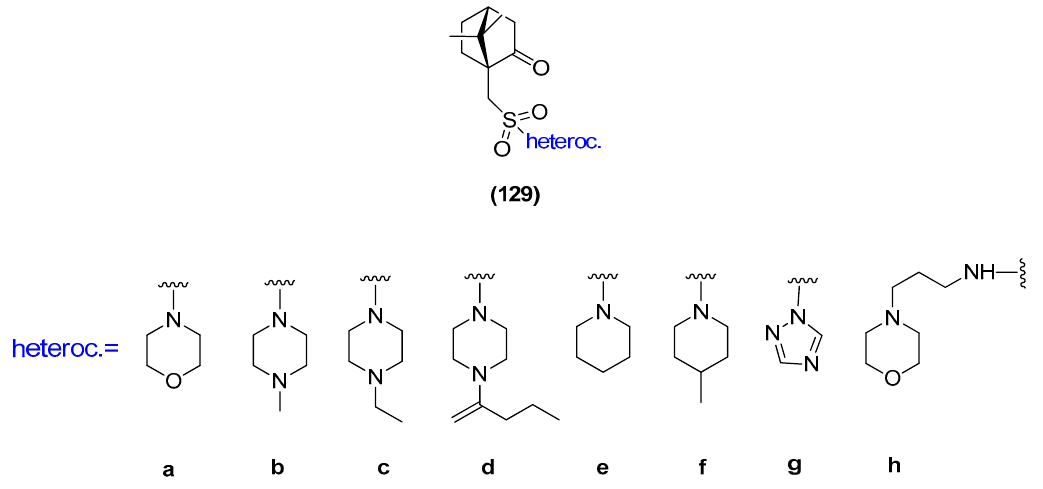
Figure 32. Quaternary ammonium salts ( 126–128 ) derived from (1 S )-(+)-camphor-10-sulfonic acid ( 125 ).